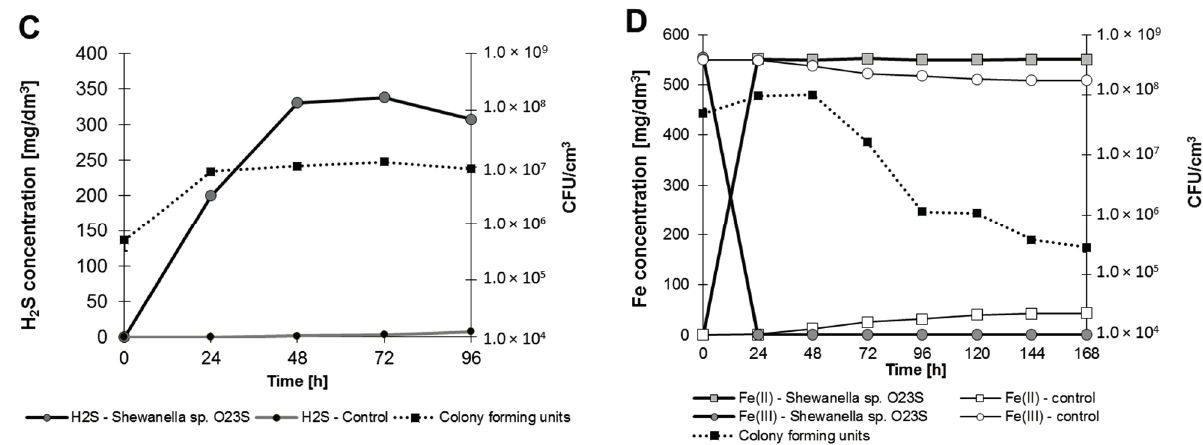
Figure 7. Anaerobic growth of Shewanella sp. O23S in minimal salt medium with 5 mM sodium lactate and 2.5 mM of electron acceptors. ( A ) Growth with 5 mM (310 mg NO 3 − /dm 3 ) sodium nitrate; ( B ) growth with 5 mM (solid phase) manganese(IV) oxide (MnO 2 ); ( C ) growth with 5 mM (560 mg S 2 O 3 2 − /dm 3 ) sodium thiosulfate; and ( D ) growth with 10 mM (558 mg Fe/dm 3 ) iron(III) citrate. SD < 5%.